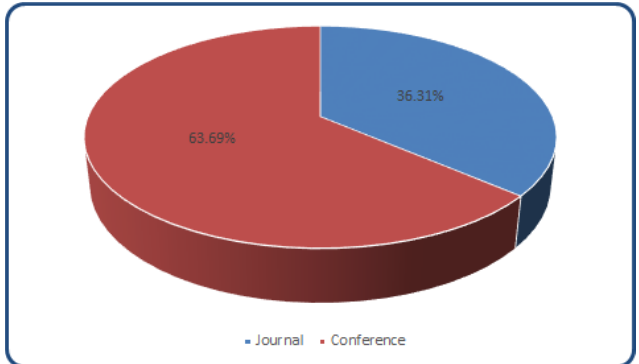
Figure 2. Editorial placement of papers.